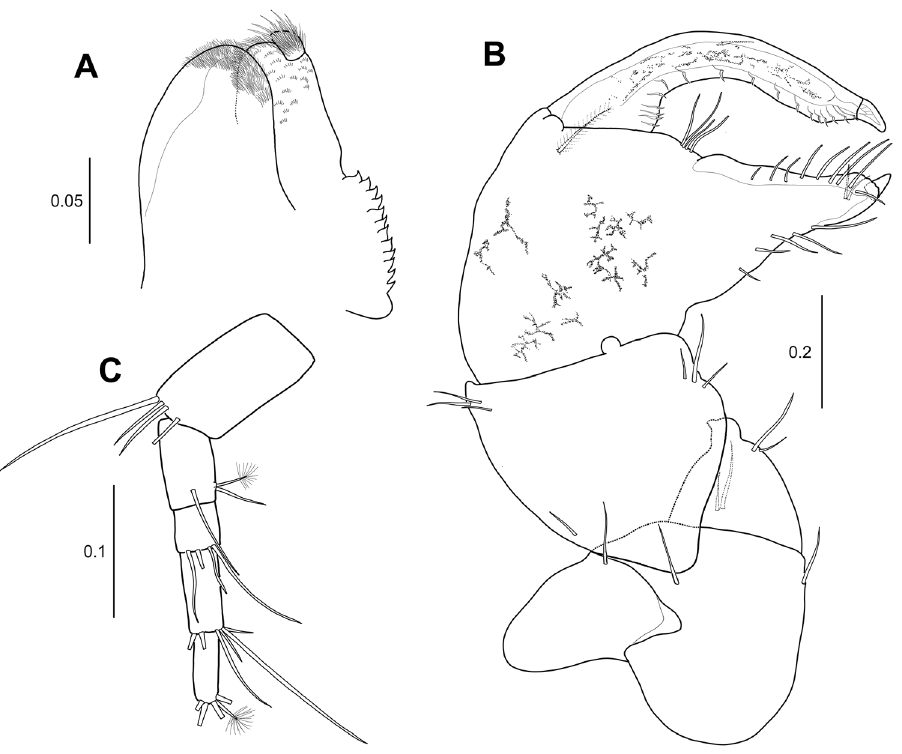
Figure 12. Hexapleomera ulsana sp. n., Jeju population, male, A labium B cheliped C uropod. Scale bars in